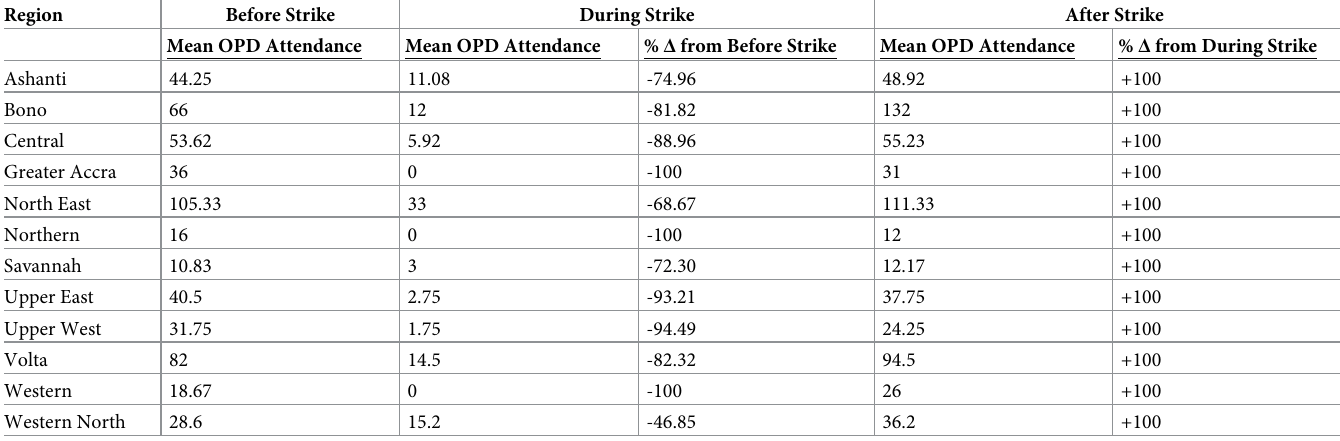
Table 12. Percentage change in the mean OPD attendance during and after strike. Region Before Strike During Strike After Strike